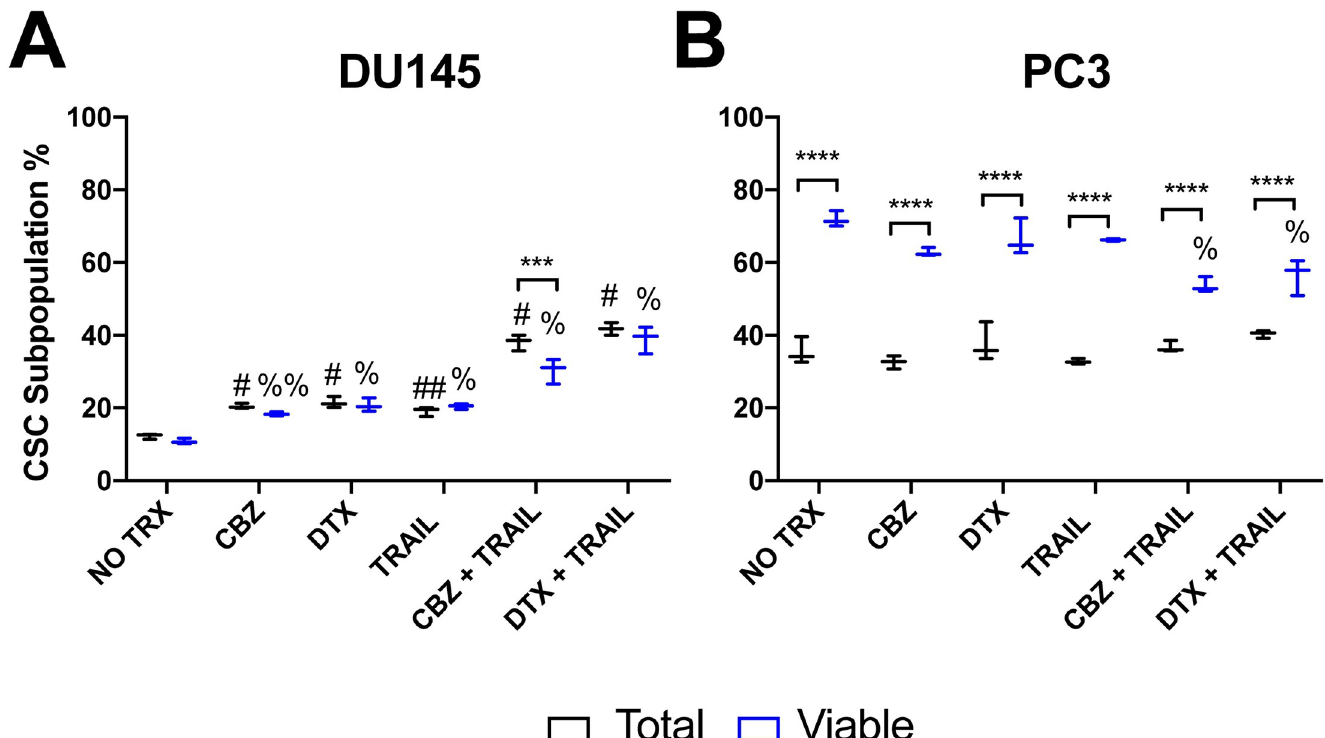
Fig 7. Analysis of CD44+/CD22- stem cell population in theviable percentage of DU145 and PC3 cells. A, B . Mean fluorescence intensity of CD44+ and CD24 + cell populations in DU145 and PC3 comparing total and viable populations using Annexin V/PI assay. The values repres ent the mean ± SD (n = 6). ��� p < 0.001, ���� p � 0.0001, significantly different from total vs viable. ## p � 0.001, # p � 0.0001, significantly different from the total population control. %% p � 0.001, % p � 0.0001, significantly different from the viable supopulation control.